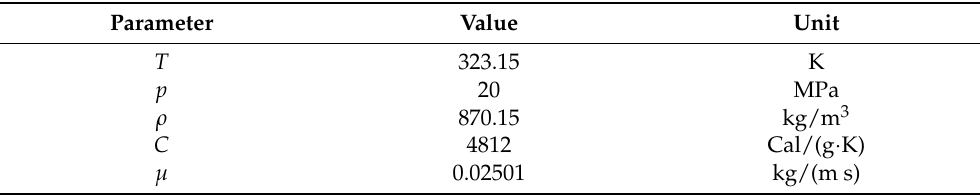
Table 2. The values of parameters associated with the working